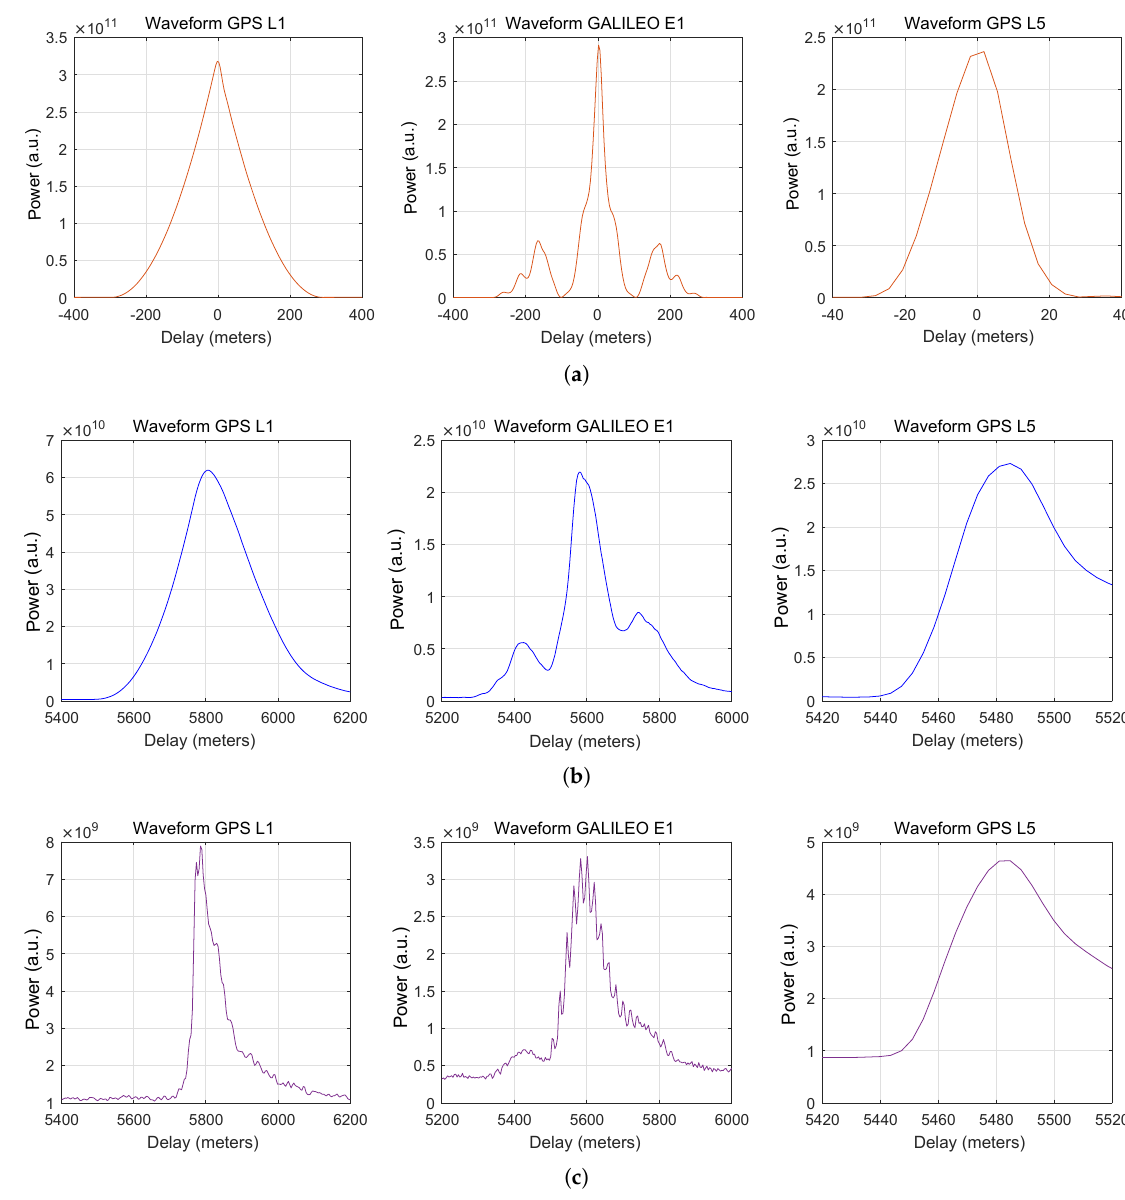
Figure 14. Power-waveform examples after beamforming. ( a ) Up-looking clean replica power-waveforms after beamforming. From left to right: GPS L1 ( SNR = 24.9 dB), GALILEO E1 ( SNR = 28.5 dB), and GPS L5 ( SNR = 27.0 dB). ( b ) Down-looking clean replica power-waveforms after beamforming. From left to right: GPS L1 ( SNR = 20.8 dB), GALILEO E1 ( SNR = 18.1 dB), and GPS L5 ( SNR = 17.7 dB). ( c ) Interferometric power-waveforms after beamforming. From left to right: GPS L1 ( SNR = 8.6 dB), GALILEO E1 ( SNR = 9.9 dB), and GPS L5 ( SNR = 8.7